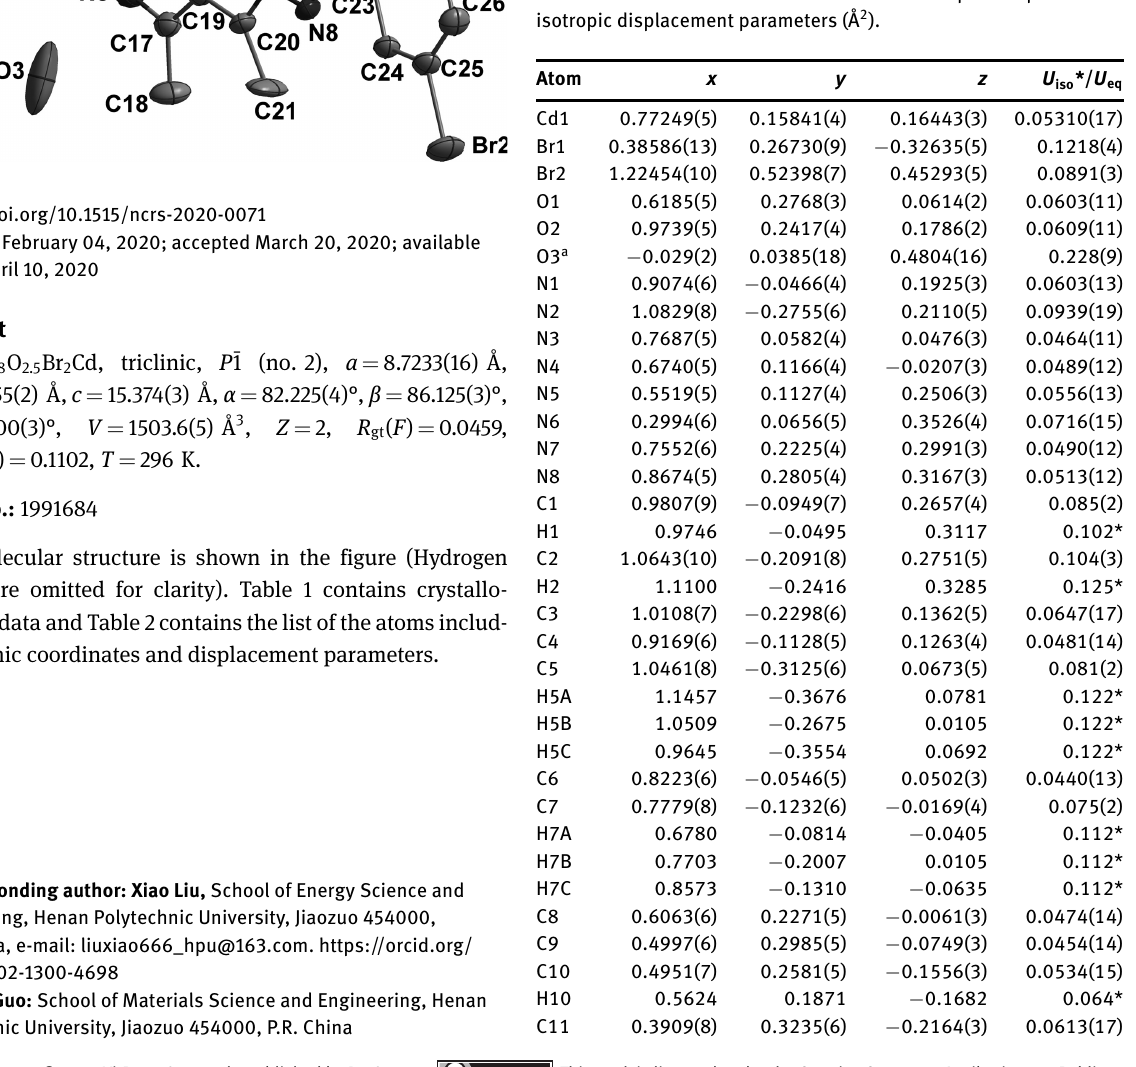
Table 2: Fractional atomic coordinates and isotropic or equivalent isotropic displacement parameters (Å 2